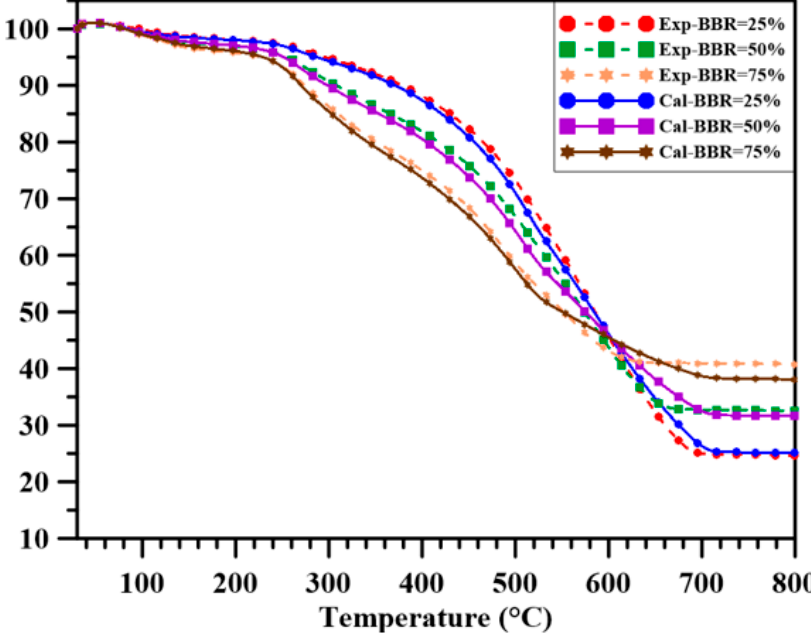
Figure 6. Synergistic effect for various sludge-coal ratios.